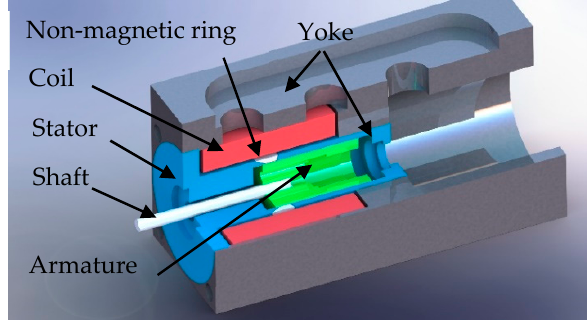
Figure 3. Geometry structure definition of the LPS.